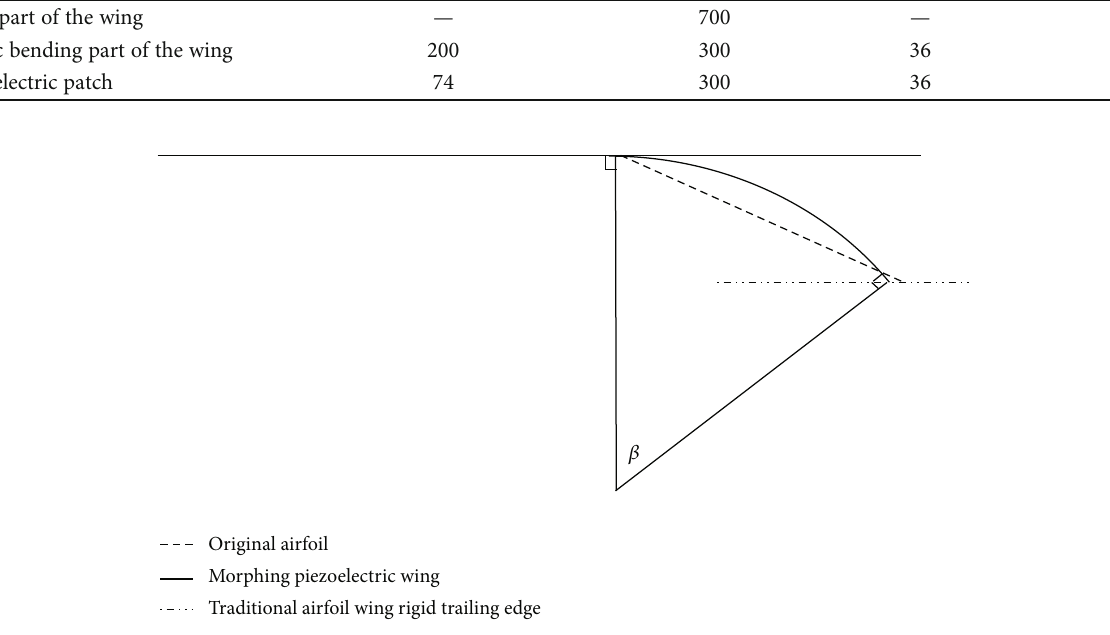
Figure 3: Wings with the equivalent de fl ection angle.